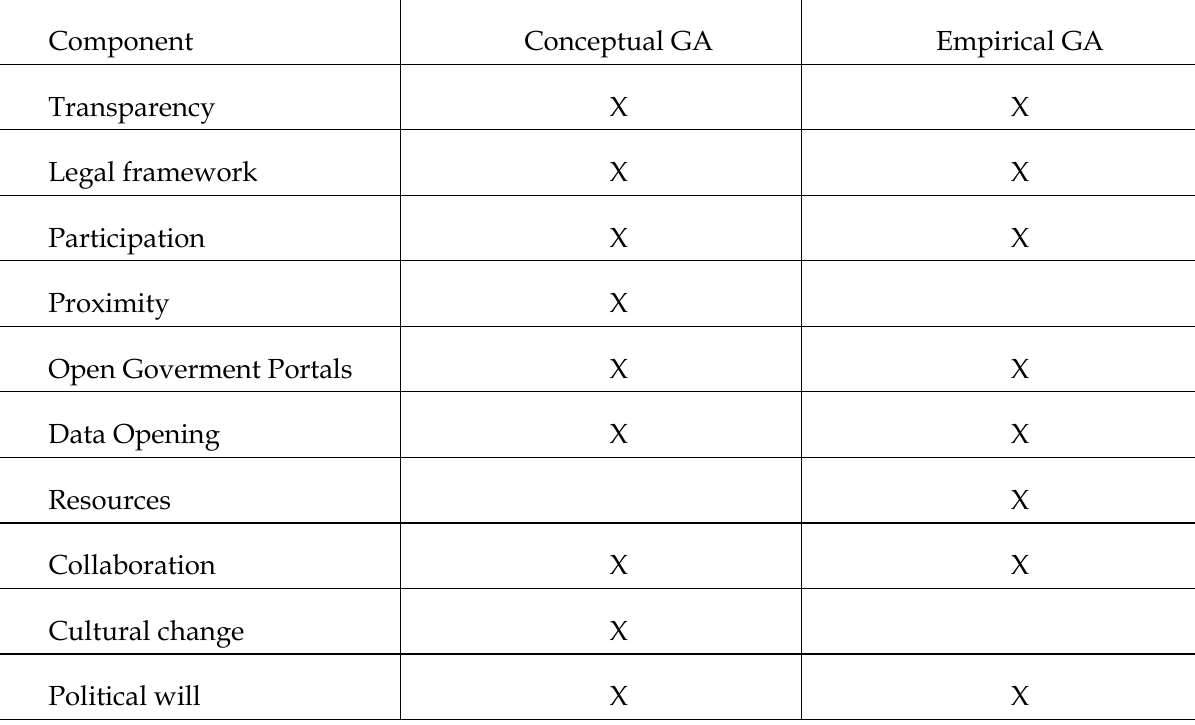
Table 1: Congruence in Open Government components in an empirical and conceptual